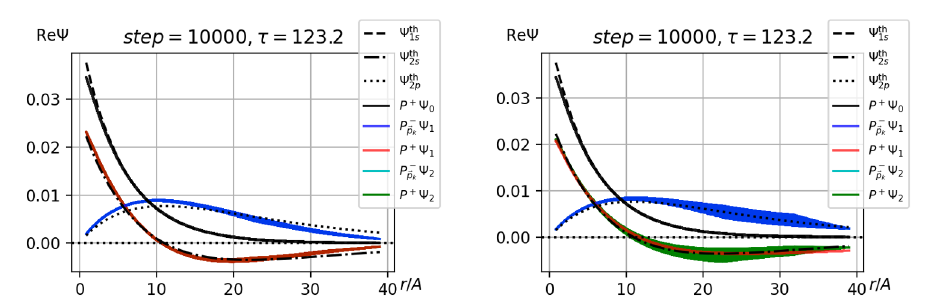
Figure 1: Figures from Ref. [1]: Coulomb potential, N = 64, A = 0 . 12 fm, M = 0 . 3 GeV. From left to right: wavefunctions of H K = H (0) terms). Observe the di ff erent finite volume e ff ects between the FDTD (left) and FFT (right) solvers. The behavior of the H (1) Ref. [1]).